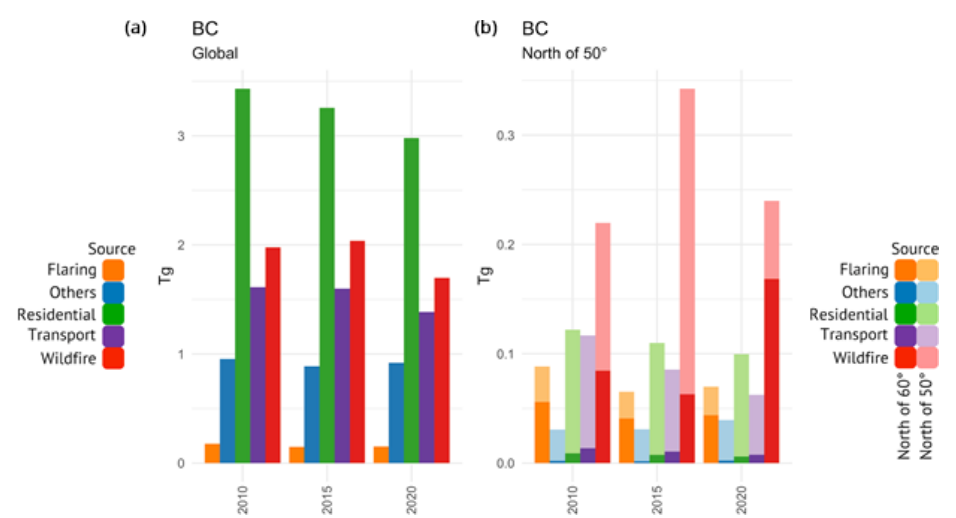
Figure 4. Annual black carbon emissions for 2010, 2015, and 2020 from four anthropogenic source sectors (residential, transport, flaring, others) from GAINS and wildfires from GFAS, presented globally (a) and (b) at 50 to 60 ◦ N (lighter colours of the cumulative bar) and north of 60 ◦ N latitude (darker colours of the cumulative bar).